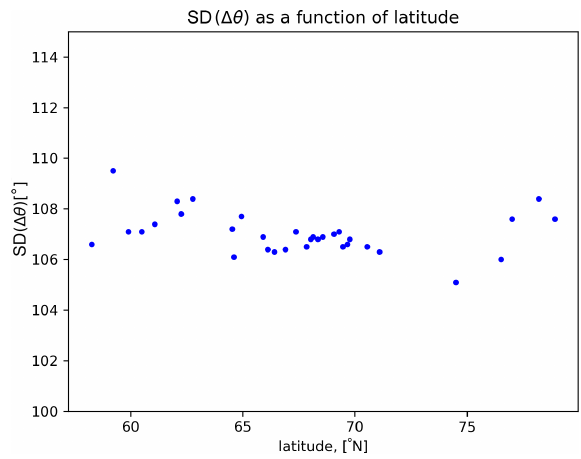
Figure 14. Standard deviation of (cid:49)θ for external d (cid:49) H / d t at IM- AGE stations as a function of latitude. Data from 1996–2018 and T = 10min.